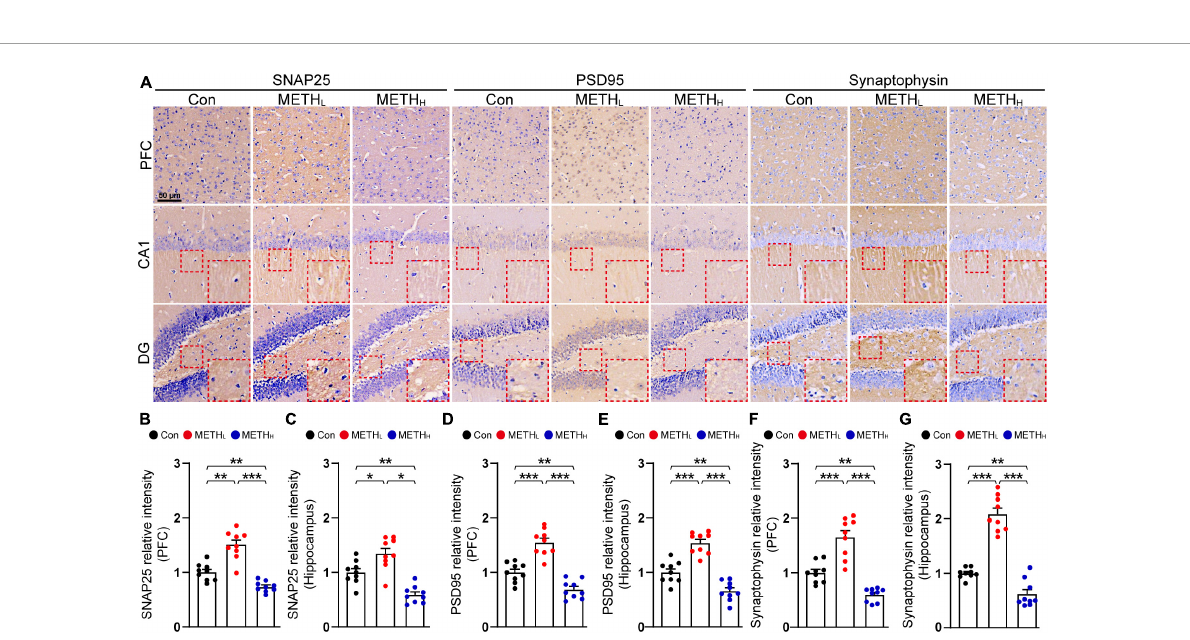
FIGURE3 Effect of low dose and high dose methamphetamine (METH) on synaptic protein levels. (A) Representative IHC images of synaptic proteins SNAP25, PSD95 and Synaptophysin. (B) Relative intensity of SNAP25 level in Con, METH L and METH H mice cortex. One-way ANOVA, F (2, 26) = 40.098, p < 0.001. (C) Relative intensity of SNAP25 level in Con, METH L and METH H mice hippocampus. One-way ANOVA, F (2, 26) = 24.861, p < 0.001. (D) Relative intensity of PSD95 level in Con, METH L and METH H mice cortex. One-way ANOVA, F (2, 26) = 43.68, p < 0.001. (E) Relative intensity of PSD95 level in Con, METH L and METH H mice hippocampus. One-way ANOVA, F (2, 26) = 48.631, p < 0.001. (F) Relative intensity of Synaptophsyin level in Con, METH L and METH H mice cortex. One-way ANOVA, F (2, 26) = 42.155, p < 0.001. (G) Relative intensity of Synaptophsyin level in Con, METH L and METH H mice hippocampus. One-way ANOVA, F (2, 26) = 88.27, p < 0.001. n = 9 sections, 3 sections per mouse. * p < 0.05, ** p < 0.01, *** p < 0.001 by one-way ANOVA and Bonferroni’s post hoc